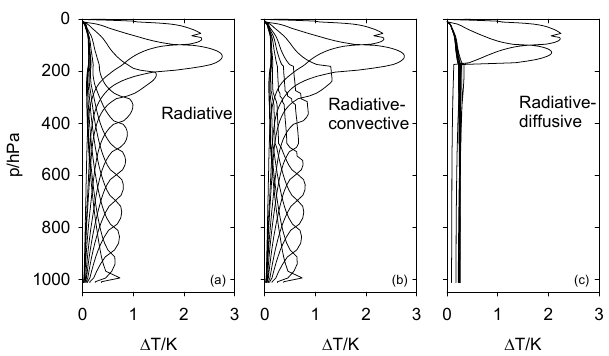
Figure 6. Temperature response versus pressure altitude for layer heating (ghost forcing) with 1Wm − 2 in 10 subsequent 100hPa pressure layers and above an adiabatic surface. Left: the “radiative case” with zero turbulent fluxes; middle: the “radiative-convective case” with convective adjustment in addition to radiative energy transport; right: the “radiative-diffusive case” with diffusive mix- ing ( κ = 100m 2 s − 1 in the troposphere, 0 in the stratosphere) in addition to radiative energy